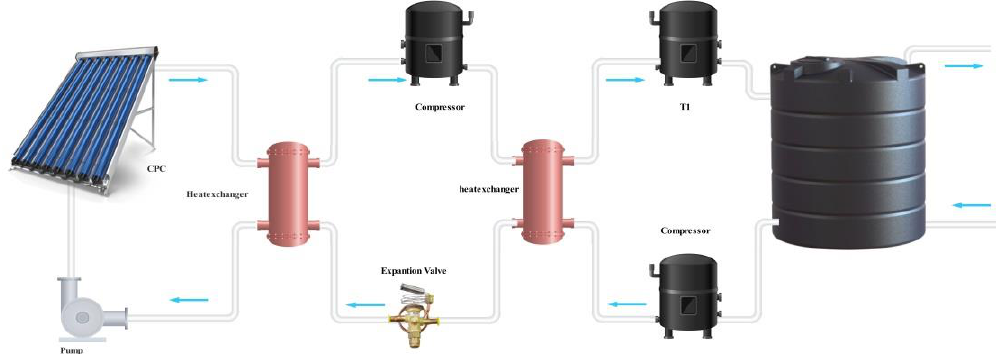
Figure 7. Simulated system.